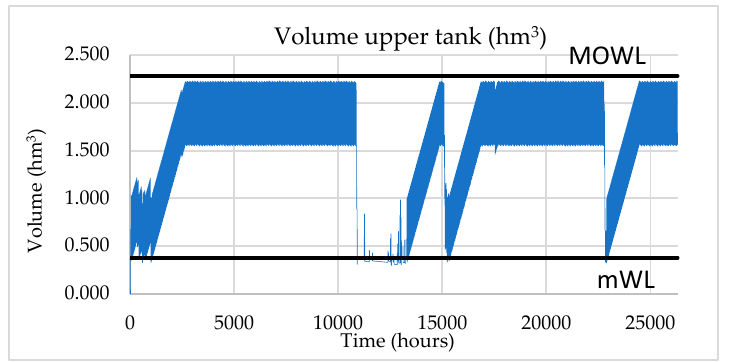
Figure 14. Behavior of the volume in the upper tank throughout the simulation, 3 years. Own source with analysis of results.